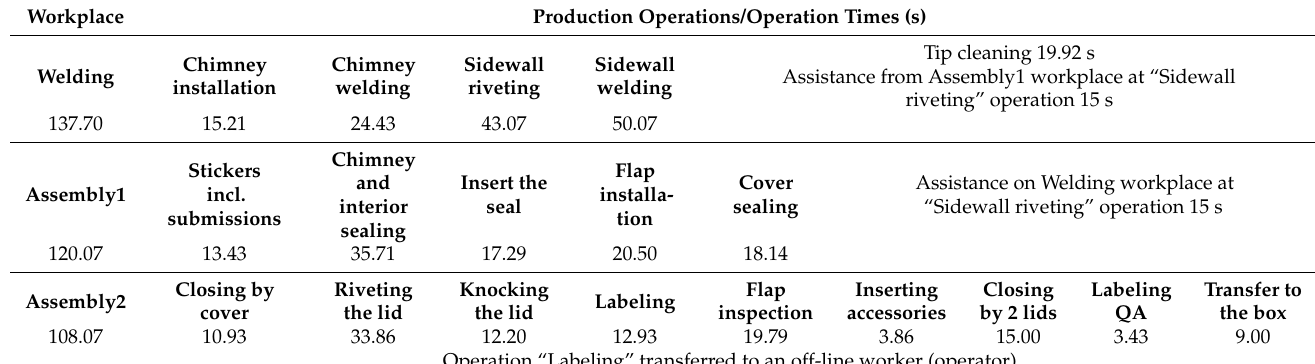
Table 1. The current state of production of TV160—workplaces, production operations, and operating times.